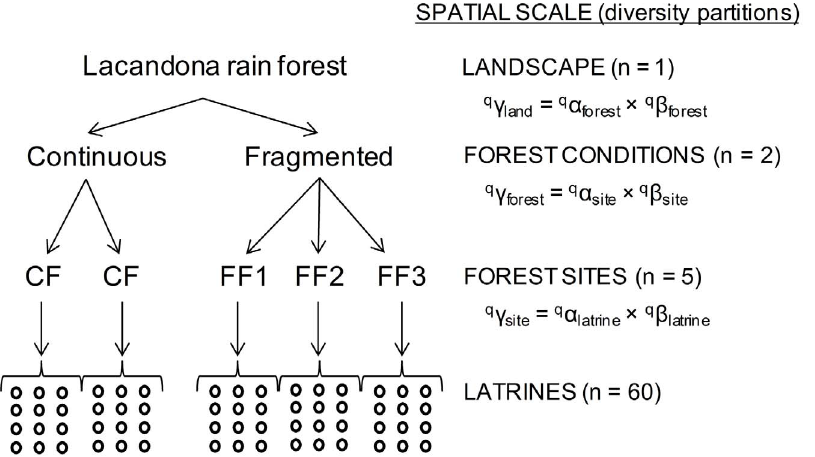
Figure 1. Hierarchically nested sampling design. The figure shows the spatial scales used to assess differences in species diversity of seeds defecated by spider monkeys ( Ateles geoffroyi ) in latrines located in continuous and fragmented forest in the Lacandona region, Mexico. Seed species diversity was partitioned into a - and b -components considering three spatial scales, from larger to smaller: (i) the diversity of the landscape ( c land ) was partitioned into mean alpha ( a forest ) and beta ( b forest ) diversities in the two forest conditions; (ii) the diversity within each forest condition ( c forest ) was partitioned into mean alpha ( a site ) and beta ( b site ) diversities in the sites; and (iii) the diversity within each site ( c site ) was partitioned into mean alpha ( a latrine ) and beta ( b latrine ) diversities in the 12 sampling latrines.